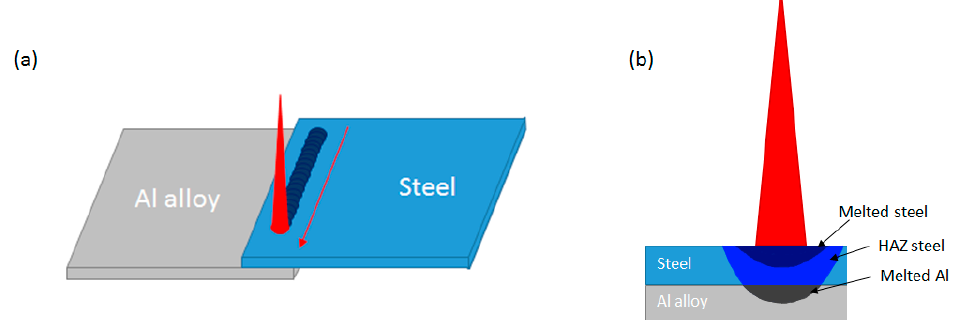
zone ( b ) zone ( b ) zone ( b